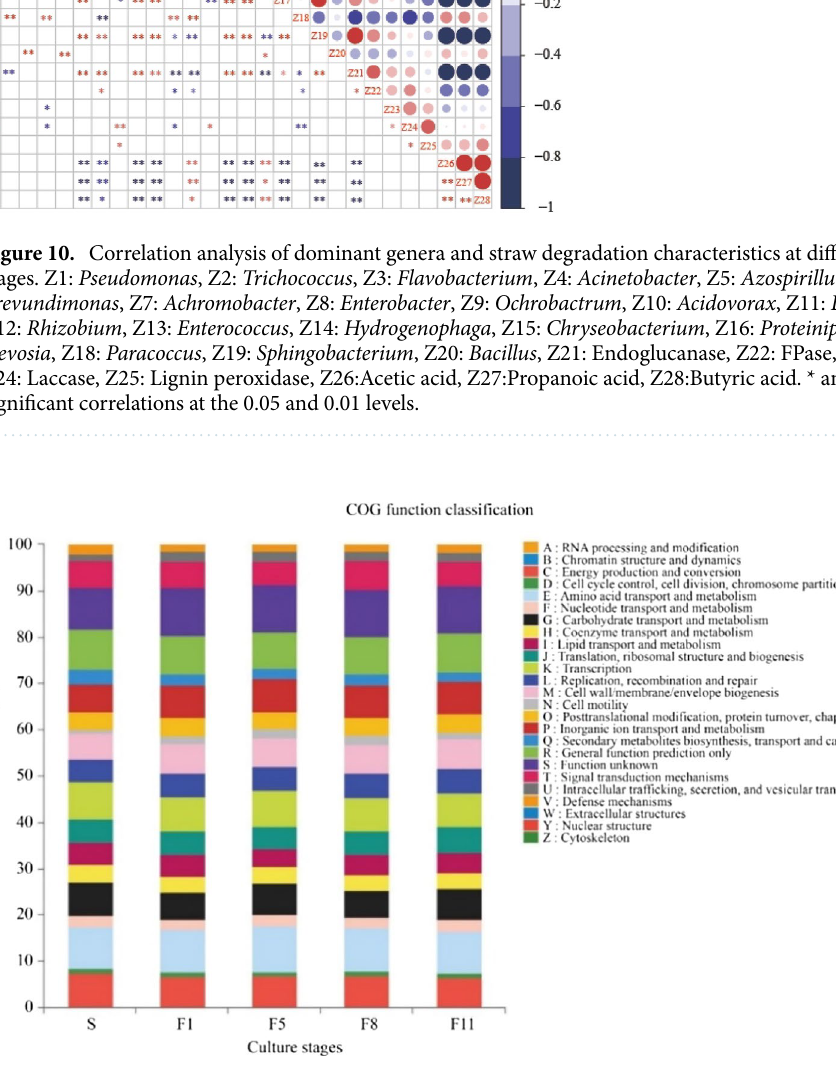
Figure 11. COG function classification at different culture